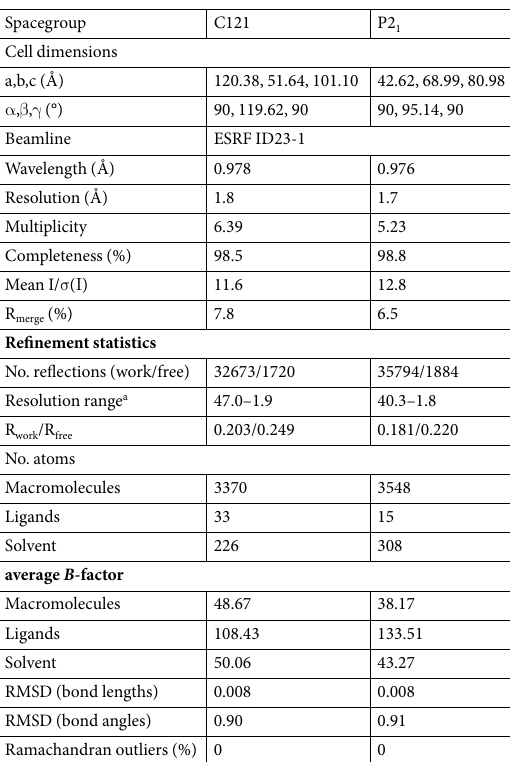
Table 1. Crystallographic statistics a . a After anisotropic